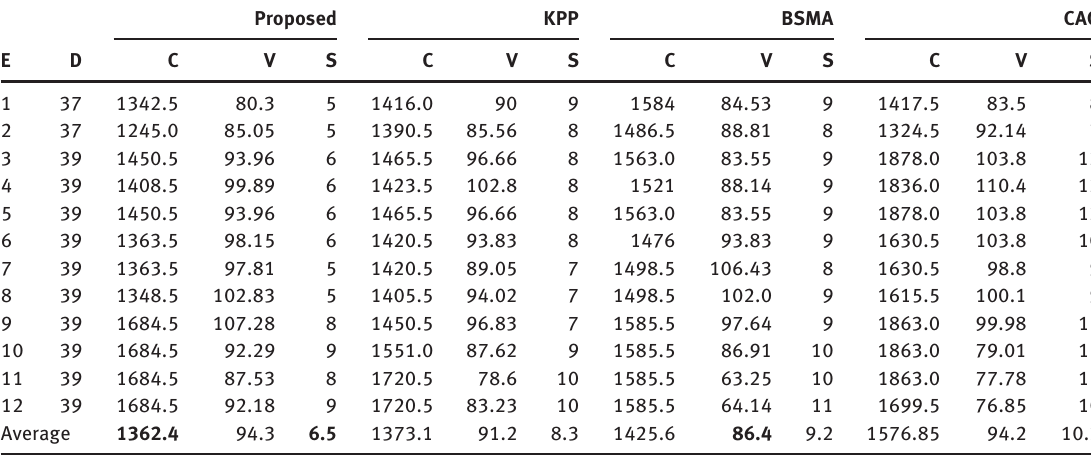
Table 1. Comparison of Dynamic Greedy Algorithm, BSMA, KPP, and CAO.